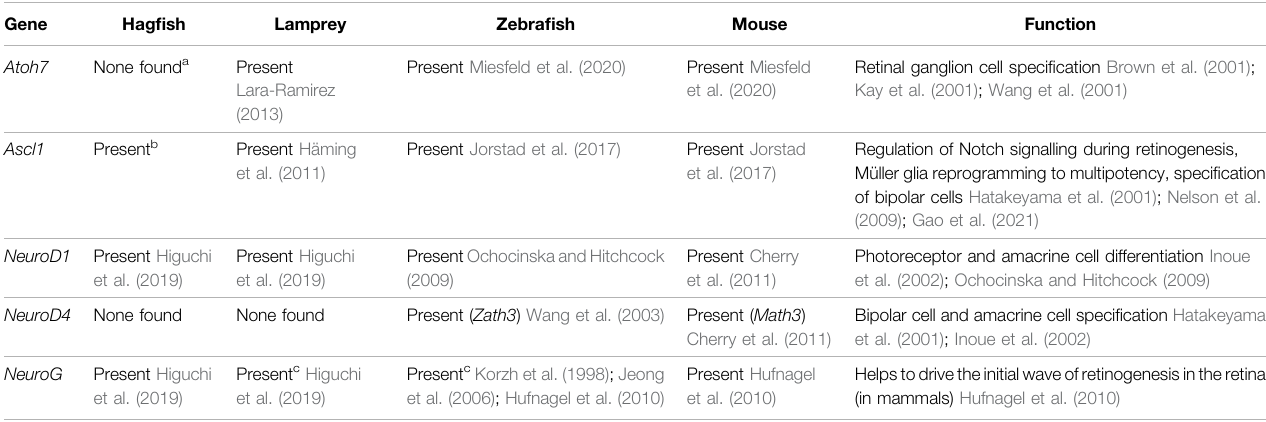
TABLE 2 | Retinal bHLH Genes across representative